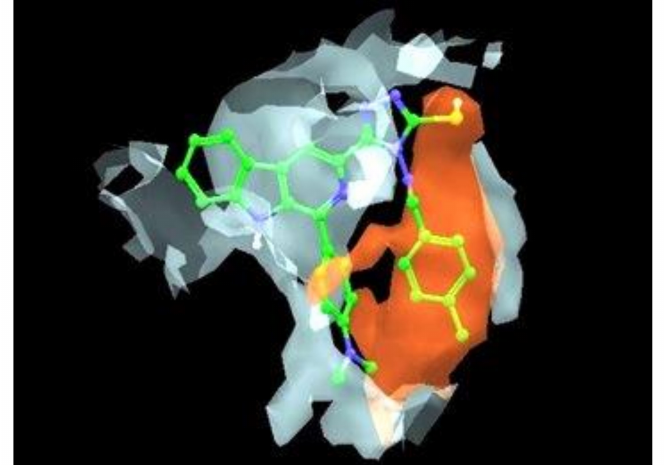
Figure 3. Docking conformation in the active site of CDK2 of most active compound ( 9 ) in the context of hydrophobic region.